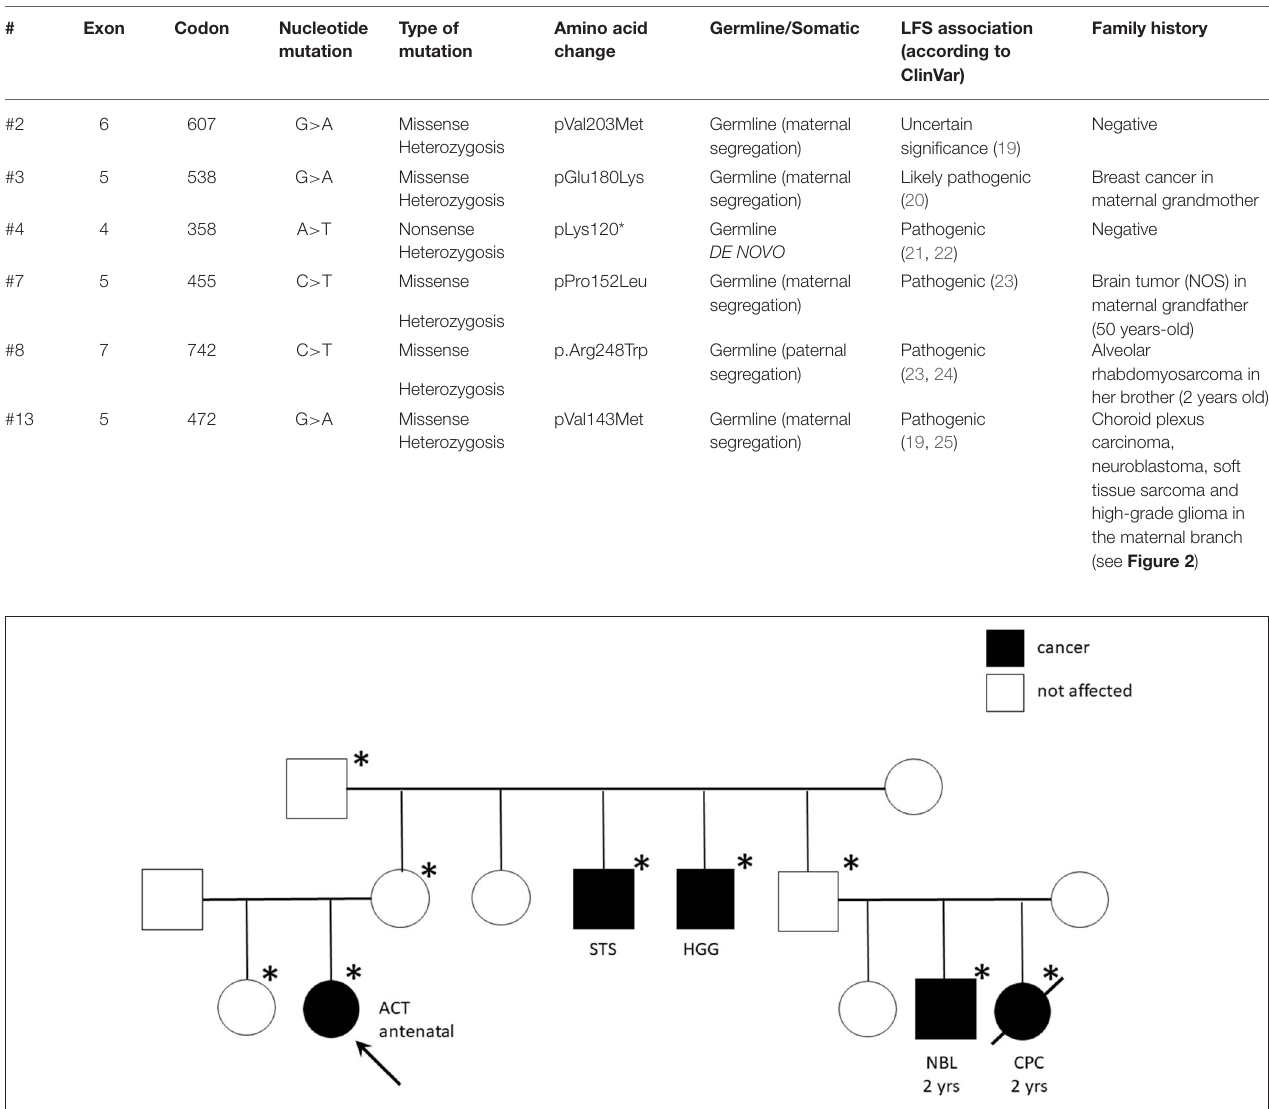
FIGURE 2 | Pedigree chart of Li-Fraumeni syndrome with TP53 mutation c427G > A (pVal143Met). The arrow indicates the proband (Case #13). Squares represent males, circles represent females, and black symbols indicate individuals, * indicates individuals carrying the mutation. ACT, adrenocortical tumor; STS, Soft Tissue Sarcoma; HGG, High Grade Glioma; NBL, Neuroblastoma; CPC, Choroid Plexus Carcinoma; yrs, years.